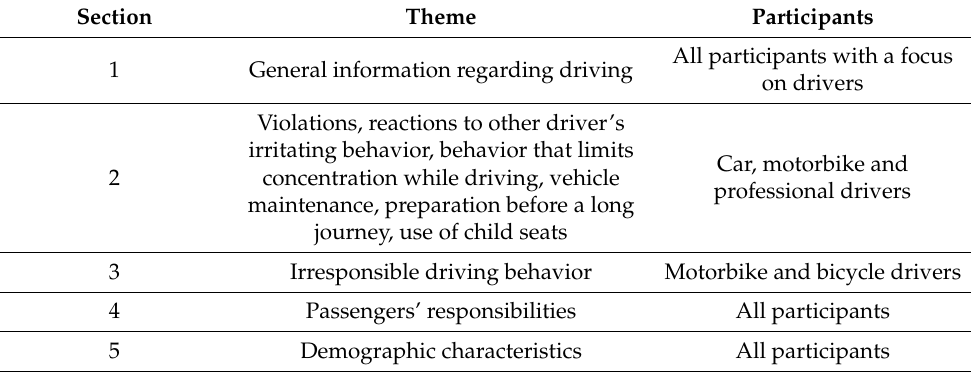
Table 1. Description of the study’s